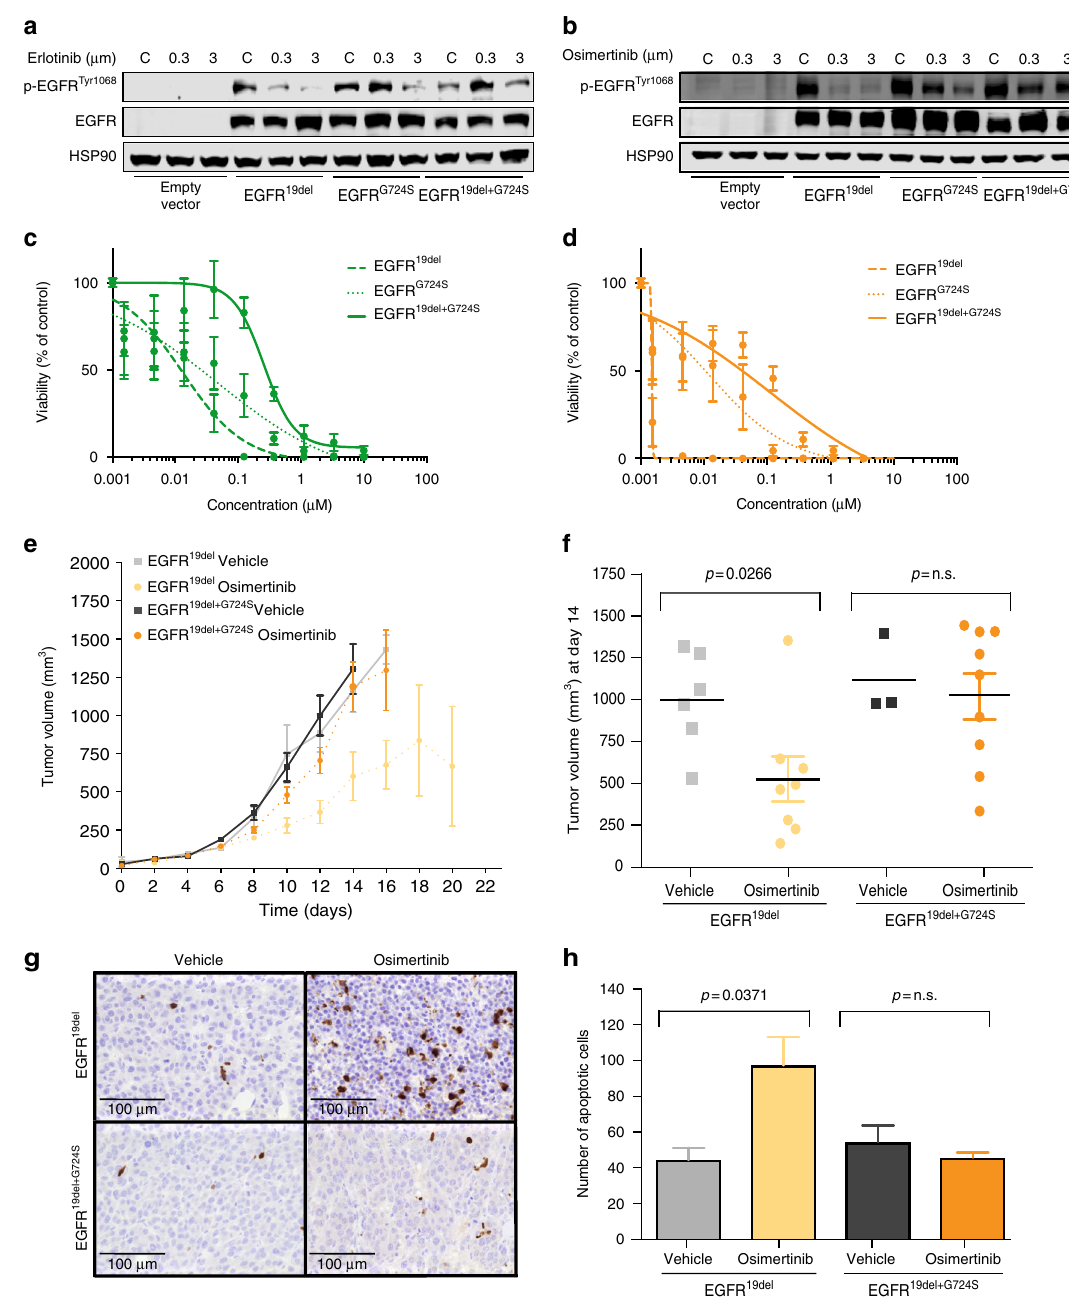
Fig. 2 EGFR G724S mediates resistance to third-generation EGFR inhibitors in vitro and in vivo. a Immunoblotting results of NIH-3T3 cells (empty vector, EGFR 19del , EGFR G724S , or EGFR 19del + G724S ) monitoring phospho-EGFR and total EGFR under erlotinib treatment (24 h). HSP90 was used as loading control. b Immunoblotting of NIH-3T3 cells under osimertinib treatment (24 h) is shown. Dose – response measurement of Ba/F3 cells expressing EGFR 19del , EGFR G724S , or EGFR 19del + G724S treated for 72 h with c erlotinib or d osimertinib. Experiments were performed at least three times. e , f Graphs show tumor volume of mice injected with NIH-3T3 EGFR 19del and EGFR 19del + G724S cells treated with osimertinib (5 mg/kg, i.p., once daily). e Tumor volumes ( EGFR 19del vehicle, n = 7 mice; EGFR 19del osimertinib, n = 8 mice; EGFR 19del + G724S vehicle, n = 7 mice; EGFR 19del + G724S osimertinib, n = 10 mice) were assessed for 20 days by longitudinal caliper measurements every second day following treatment initiation. f Tumor volumes were quanti fi ed after 8 days of treatment. Volume changes in the osimertinib treatment cohort (dark gray and green) were compared with the vehicle-treated control group (light gray and green). Each dot represents a single tumor per mouse. Signi fi cance is calculated by two-tailed Student ’ s t test, n.s.: non-signi fi cant. g Representative images of Cleaved Caspase-3 stainings. Tumors of mice bearing NIH-3T3 EGFR 19del or EGFR 19del + G724S cells were treated with vehicle solution HPMC (0, 5%) or osimertinib. Scale bar 100 μ m. h Quanti fi cation of Cleaved Caspase-3 staining. Number of apoptotic cells in the osimertinib-treated cohort (dark gray and green) was compared with the vehicle-treated control group (light gray and